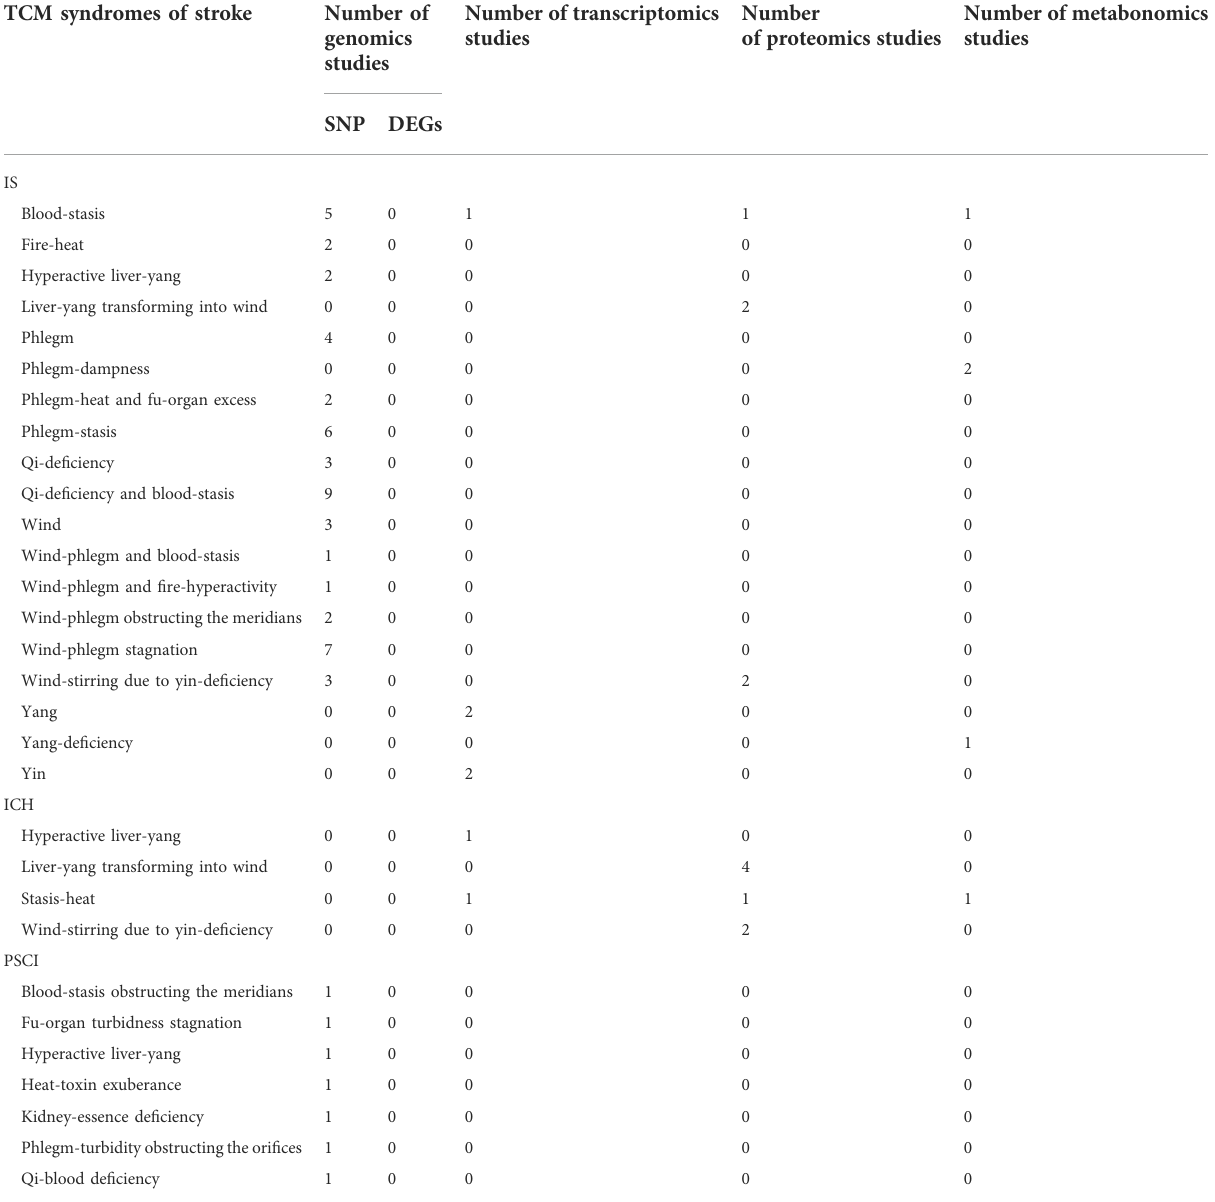
TABLE 5 Summary of TCM syndromes and omics methods in studies